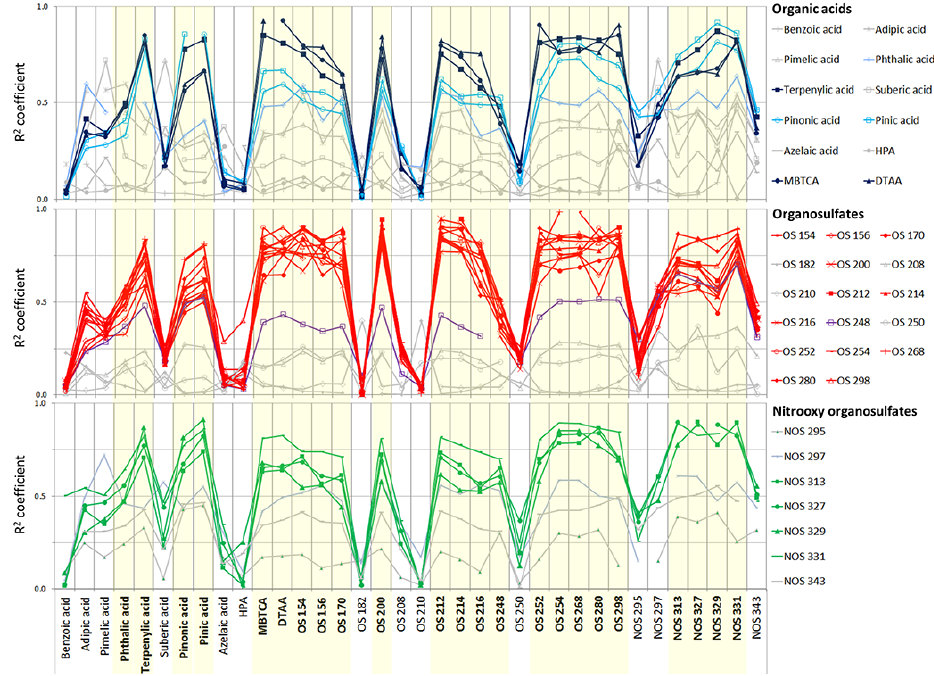
Figure 2. Correlations between organic acids, organosulfates and nitrooxy organosulfates with other detected species in each sample through- out the sampling period (excluding those with too few measurements), expressed as correlation coefficient ( R 2 ) . The results show R 2 coeffi- cient averaged from the two sites. High R 2 values (>0.5) were found among a specific group of species (yellow shade), suggesting common sources. A few other species, including pinonic acid, pinic acid, phthalic acid, and OS 248 also partly followed the correlation pattern.